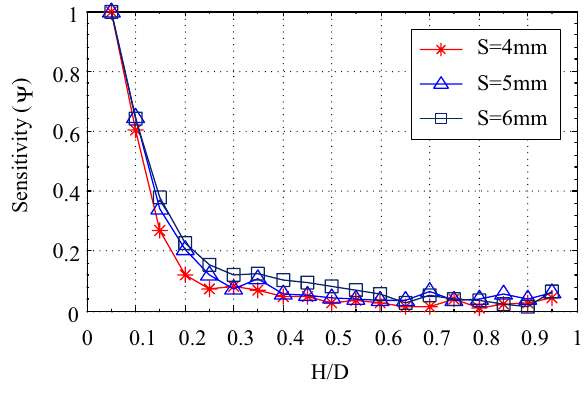
Fig. 6 Sensitivity distribution curves of MCP1 under three different S values at z = 0: D = 20 mm, h = 2 mm and d = 1.5